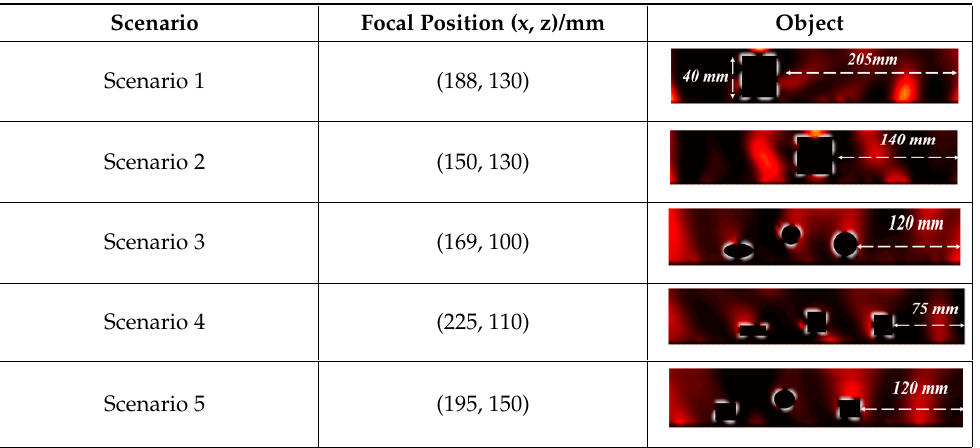
Table 1. Define of different Table 1. Define of different scenarios. Table 1. Define of different scenarios. Table 1. Define of different scenarios. Table 1. Define of different scenarios. Table 1. Define of different scenarios.